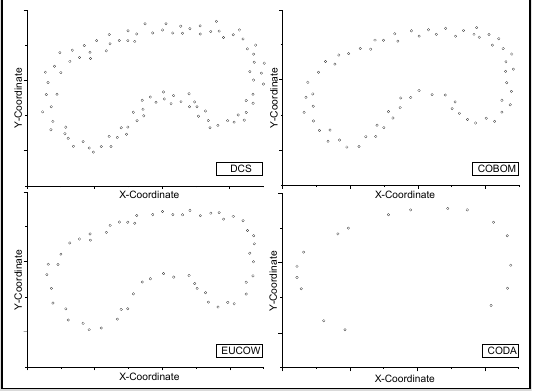
Figure 5. Experimental results for quality vs.